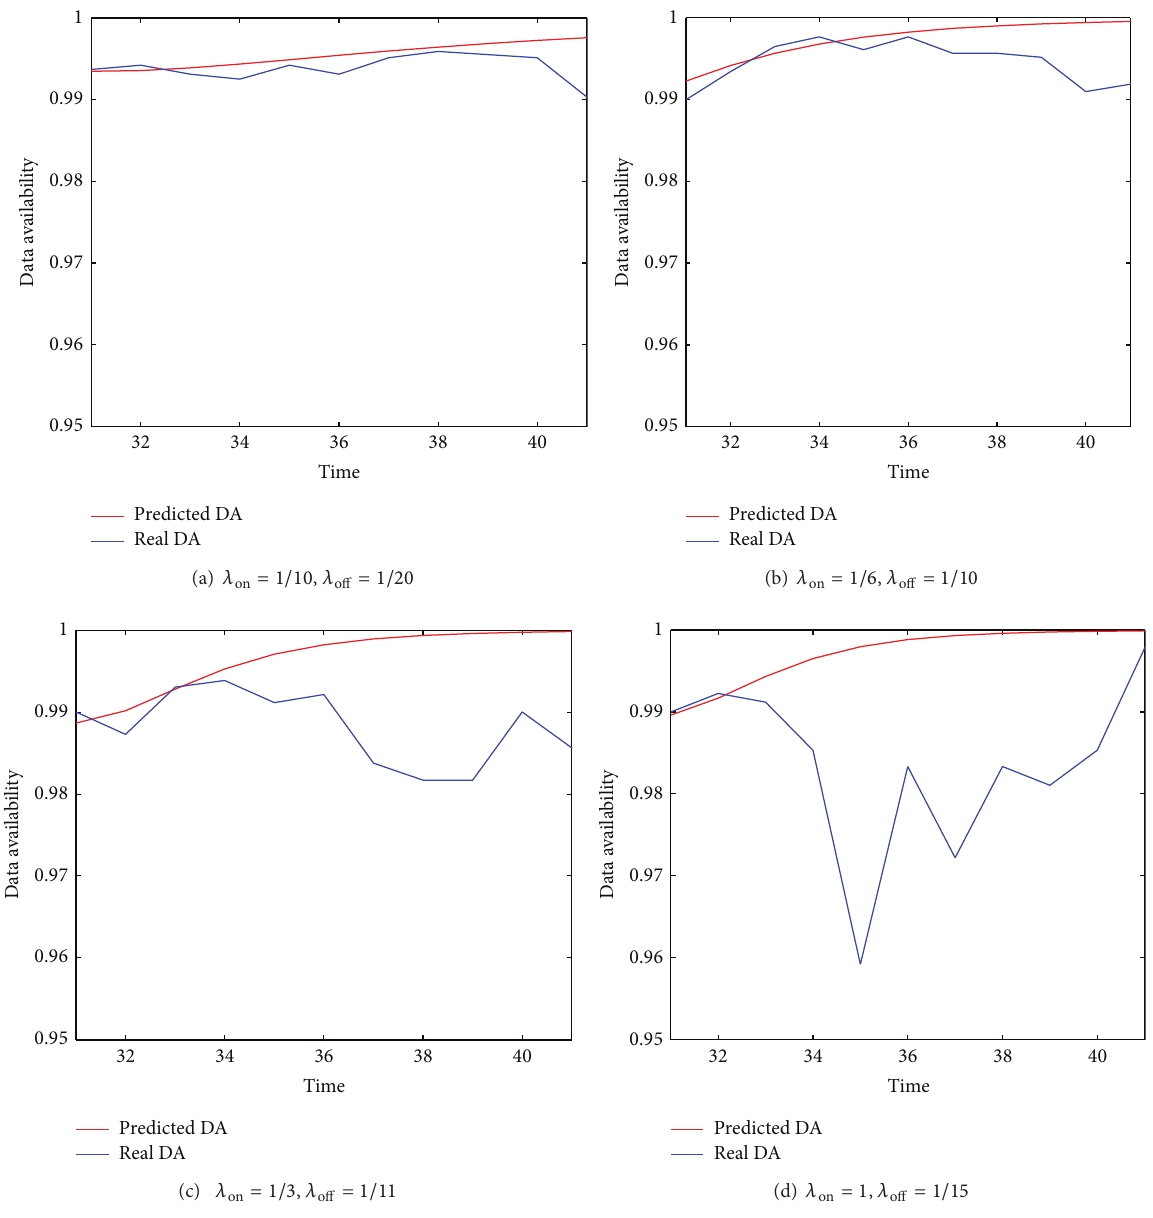
Figure 8: The accuracy of the on-the-fly prediction of